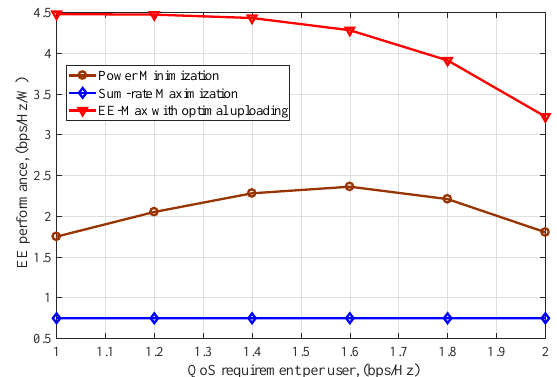
Figure 1. The average EE performance versus per-user QoS threshold. Circle cell structure with radius 250 m is setup with a MBS equipped with 10 antennas at centrally coverage network, 4 SBSs equipped with 2 antennas and 14 single- antenna users randomly distributed. Other simulation parameters are as follows: carrier frequency = 2 GHz, Bandwidth = 10 MHz, transmit power of MBS and SBSs = 43 dBm and 30 dBm, path-loss of MBS and SBS 128 . 1 + 37 . 6 log R dB and 10 R dB (R in km), noise power density − 174 140 . 7 + 36 . 7 log 10